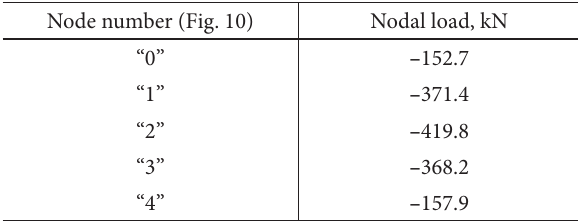
Table 3. Data for computation of axial forces in rigid flange (stage I of analysis)